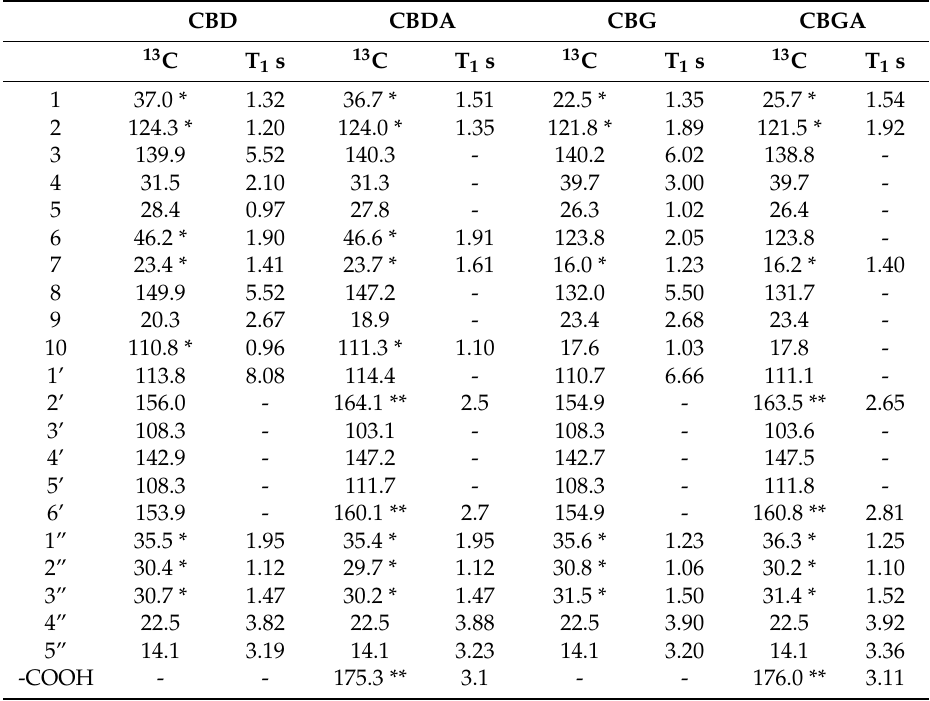
Table 2. 13 C assignments for hemp cannabinoids in CDCl